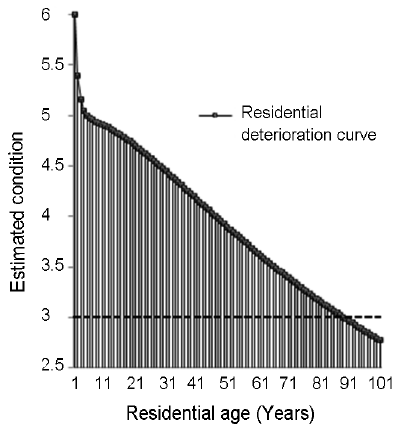
Fig. 10. Residential deterioration curve